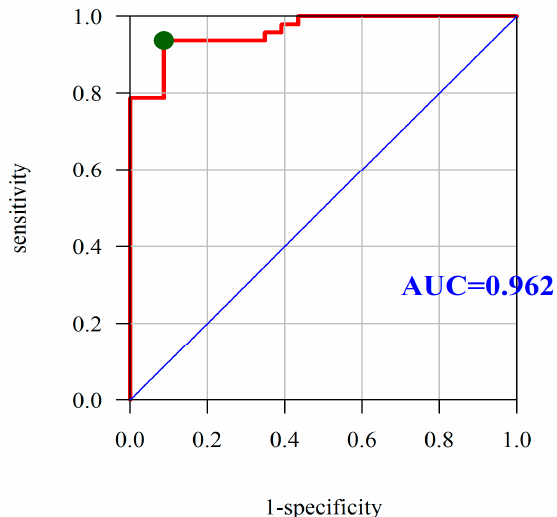
Figure 2. Diagnostic utility of PON-1 was assessed as the predictor of Crohn’s disease based on the analysis of ROC curves. Abbreviations: PON-1, paraoxonase-1; ROC, receiver operating characteristic; AUC, area under the ROC curve; red line mean AUC: area under the ROC curve and green point mean the true cut-off value of the ROC curve.